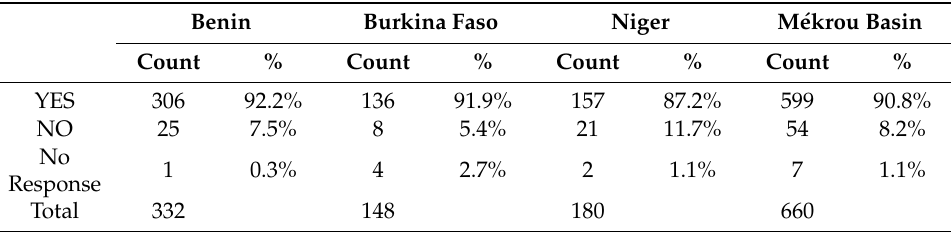
Table 9. Are you willing to pay (WTP) for the hypothetical development of the Mékrou River (dmr)